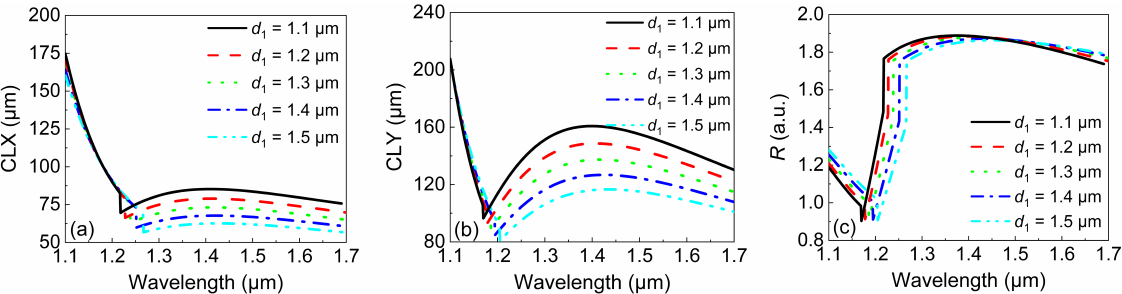
Figure 5. The variations in ( a ) the CLX and ( b ) CLY with the wavelength under different values of d 1 . ( c ) The variations in R with the wavelength under different values of d 1